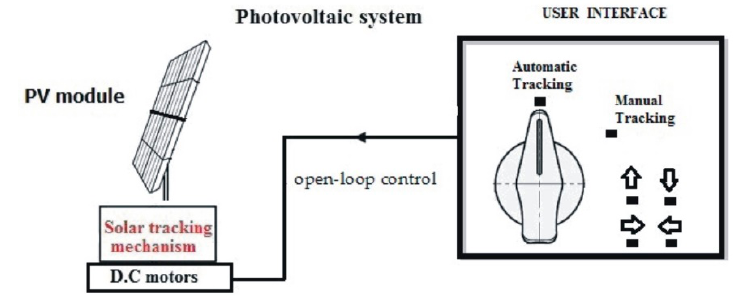
Figure 7. Proposed solar tracking control.